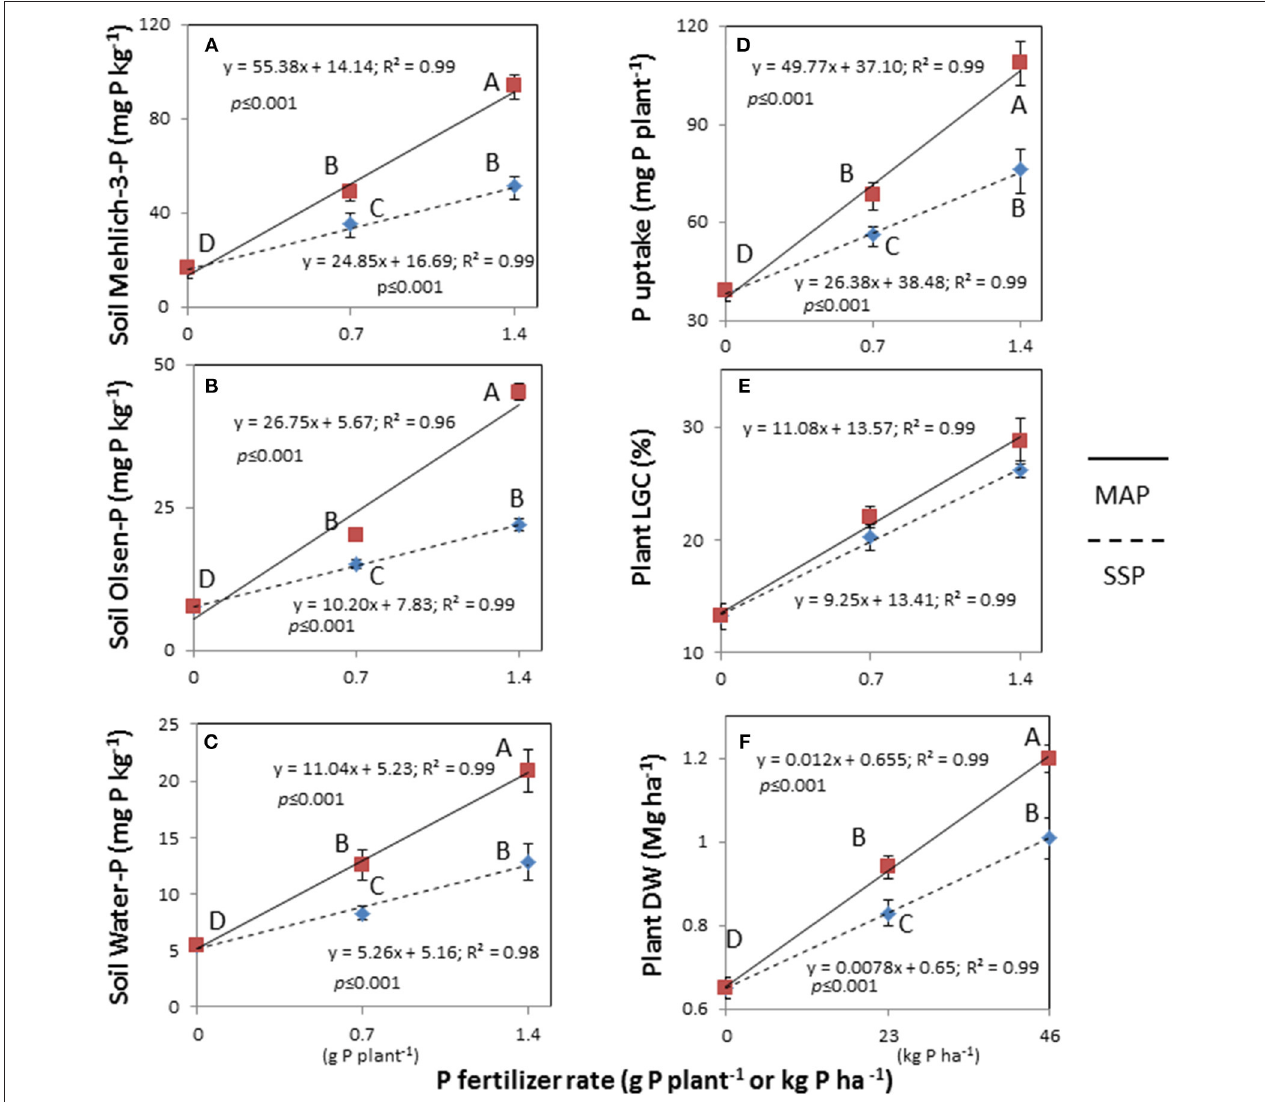
FIGURE 1 | Linear response of soil Mehlich-3-P (A) , Olsen-P (B) , and water-P (C) concentrations, plant’s P uptake (D) , living ground cover (LGC) index (E) , and dry weight (DW) (F) on two fertilizers (single superphosphate, SSP and mono-ammonium phosphate, MAP) at two fertilizer rates (0.7 and 1.4g P plant − 1 ) and untreated. Treatments were: MAP, continuous line with red squares; SSP, dotted line with blue rhombus. Means with the same letter are not significantly different at the 0.05 probability level. Bars indicate standard deviation.